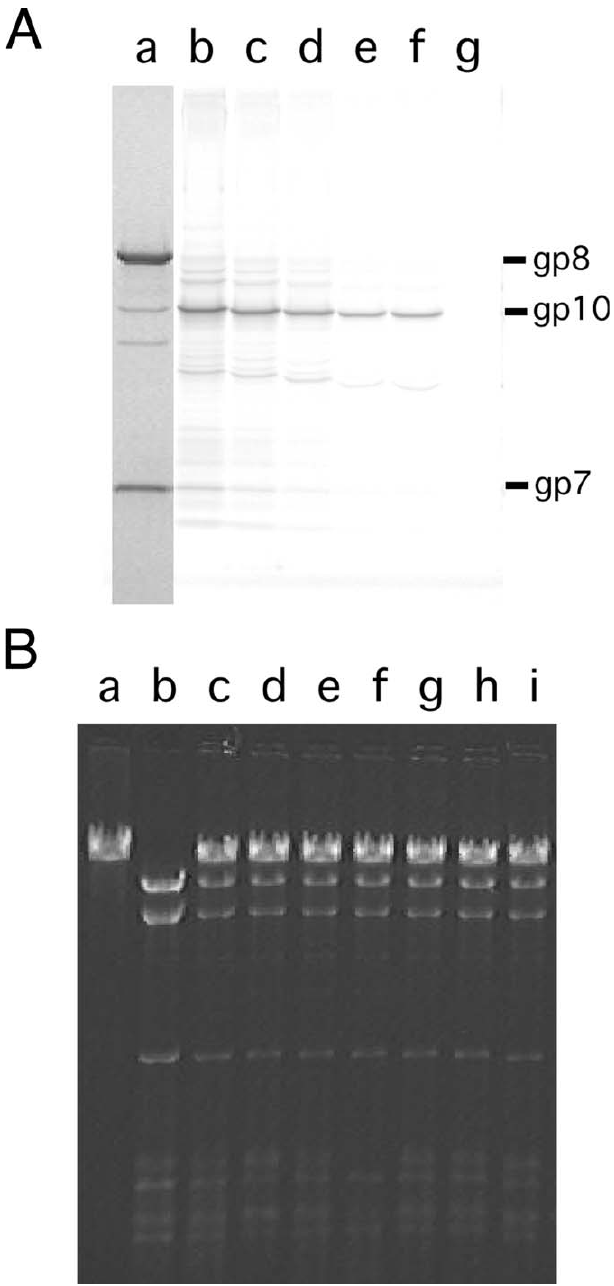
Figure 3. Dye Labeling and DNA Packaging of u 29 Proheads (A) SDS-PAGE of 170C-connector-mutant proheads. Protein stain of proheads shows the structural components gp8 (capsid), gp8.5 (fiber), gp10 (connector), and gp7 (scaffold) in lane (a). Fluorescence scan of the gel showing labeled proheads with various amounts of dye per gp10 monomer used in labeling reaction: 1 dye per gp10, lane (b); 0.5 dyes per gp10, lane (c); 0.25 dyes per gp10, lane (d); 0.125 dyes per gp10, lane (e); 0.0625 dyes per gp10, lane (f); and no dye, lane (g). The bands in the fluorescence scan with no match in the protein stain originate from highly reactive but quantitatively minor E. coli proteins. (B) DNA packaging tested by nuclease (EcoRI) protection assay using the labeled proheads from (A). Lane (a) shows input DNA-gp3; lane (b) shows a negative (no ATP) control. Packaged DNA is protected from nuclease digestion. Packaging activity is unaffected by dye labeling when compared to a 193C packaging control, lane (c). (B) Shows labeled proheads from (A), ranging from 1 dye per gp10, lane (d); 0.5 dyes per gp10, lane (e); through to no dye, lane